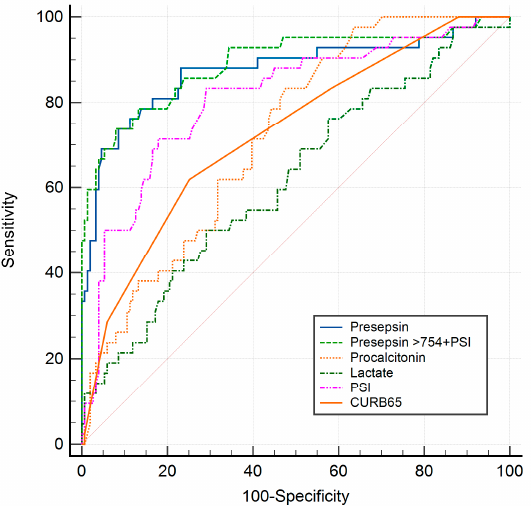
Figure 3. The ROC curves of presepsin, procalcitonin, lactate, PSI, CURB-65 score, and combination of presepsin > 754 pg/mL and PSI for 30-day mortality.